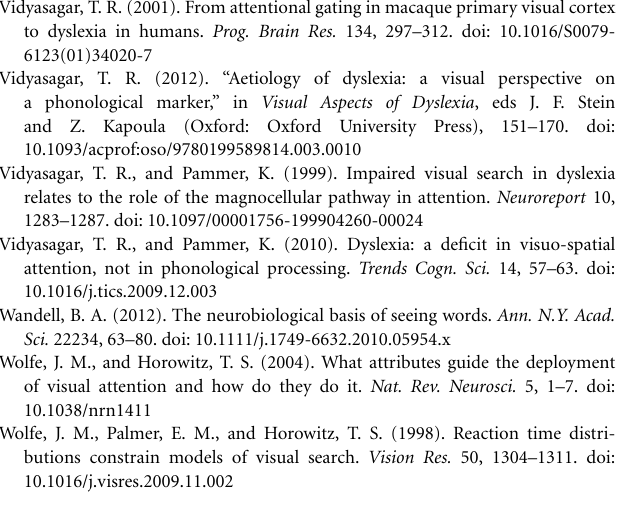
Citation: Vidyasagar TR (2013) Reading into neuronal oscillations in the visual system: implications for developmental dyslexia. Front. Hum. Neurosci. 7 :811.